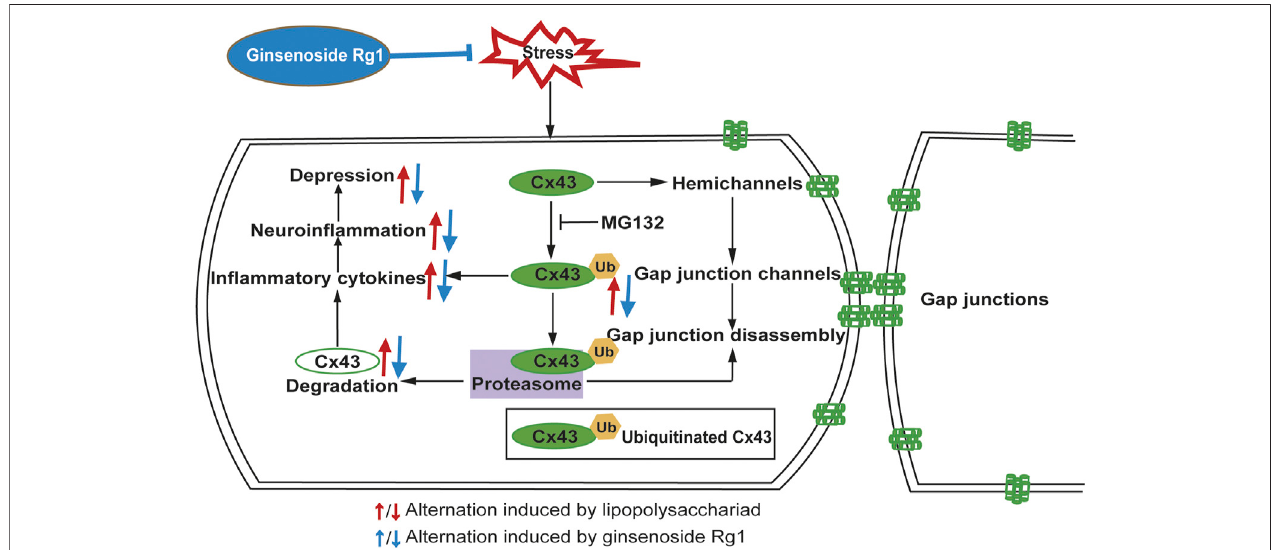
FIGURE11| Schematicillustrationofthesignalingpathway involvedintheanti-in fl ammatoryandanti-depressantactions ofRg1onCx43 ubiquitination.Stresses, such as CUS or LPS treatment upregulates pro-in fl ammatory cytokines activation, which in turn aggravates depression. Rg1 may ameliorate neuroin fl ammation via suppression of Cx43 ubiquitination to attenuate